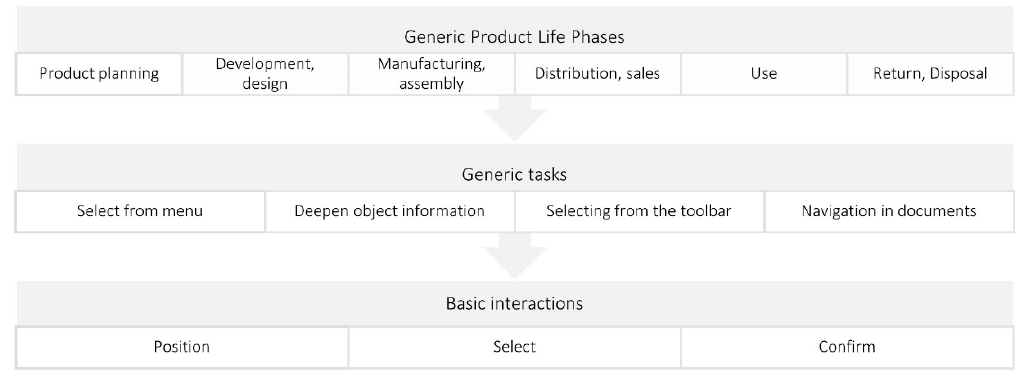
Figure 2. Representations of prototypical tasks in an AR system [3,47].